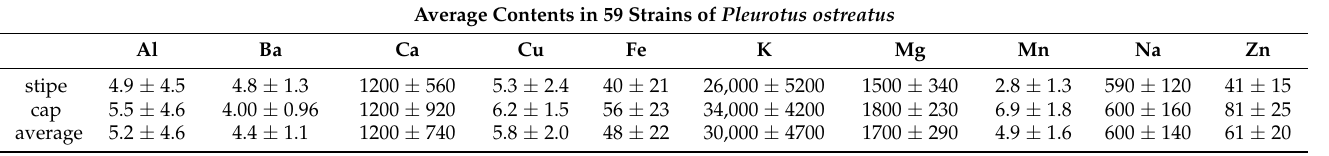
Table 3. The content of selected substances in the stipe and in the cap (mg kg − 1 DM). Average Contents in 59 Strains of Pleurotus ostreatus